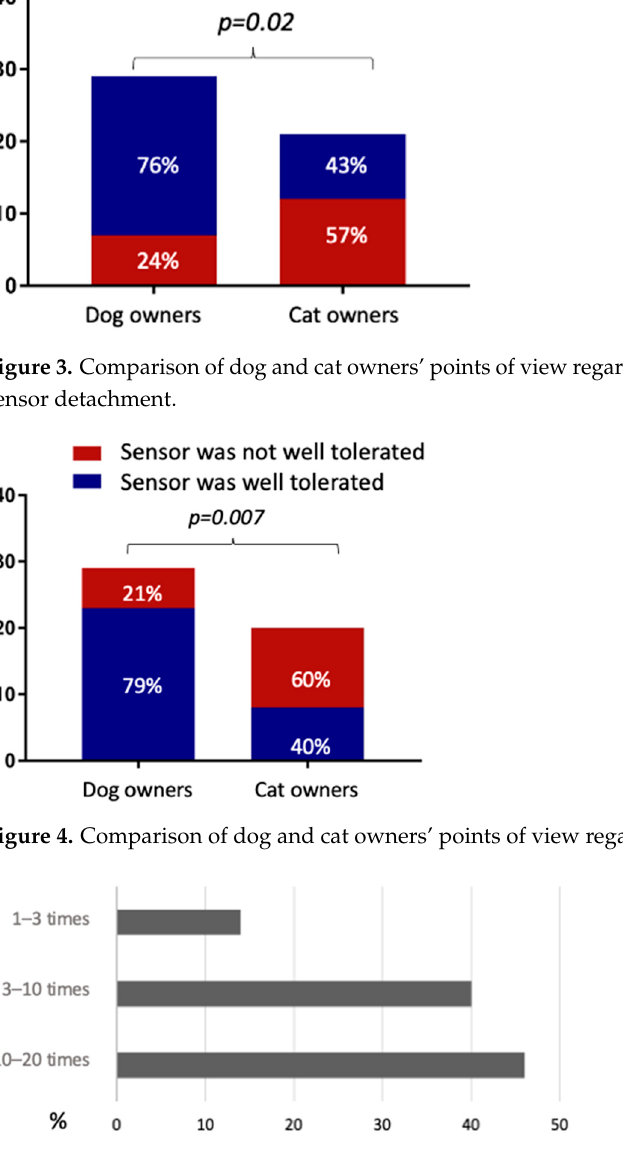
Figure 5. Number of sensor scans per day carried out by dog and cat owners when using the flash glucose monitoring system.